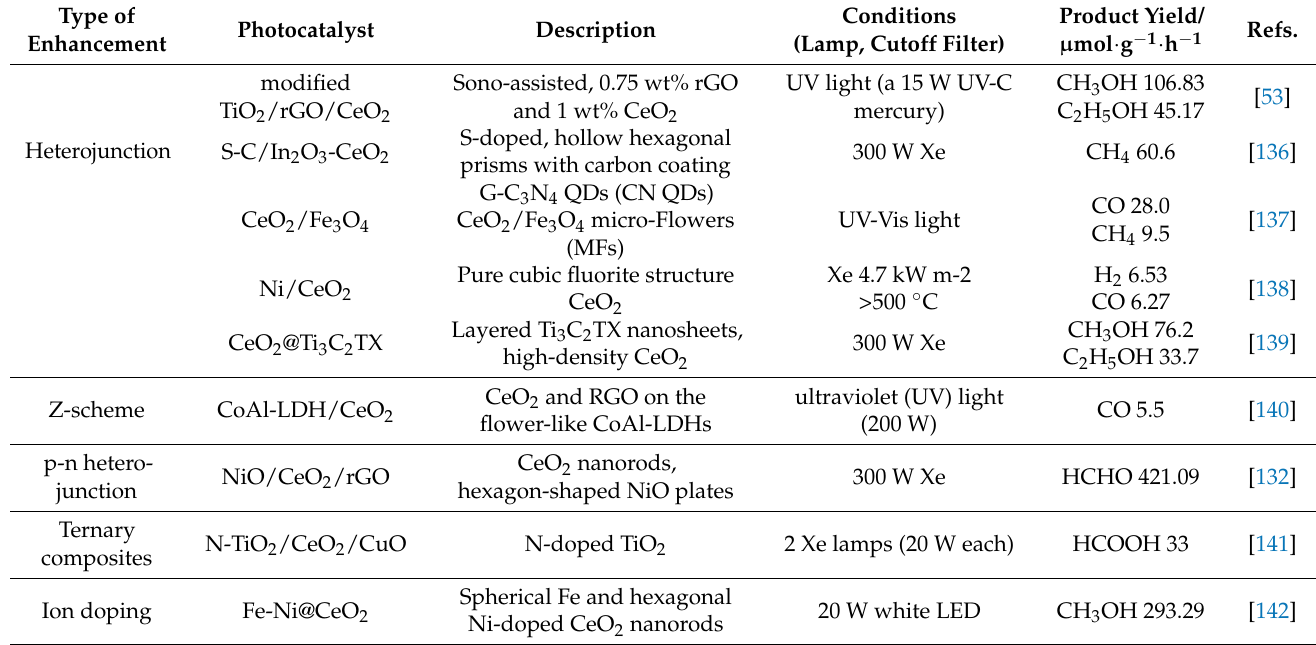
Table 5. Summary of the recent results on the photoreduction of CO 2 by CeO 2 -based